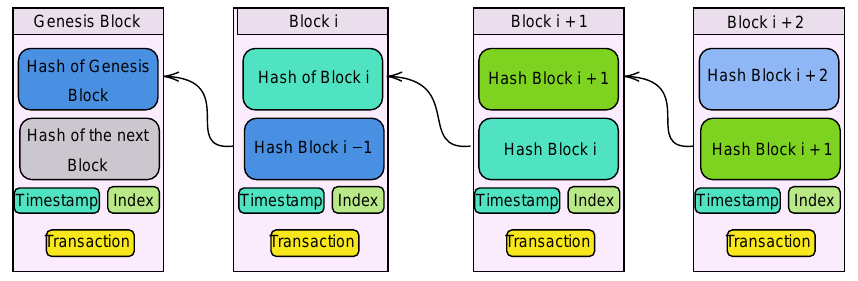
Figure 6. A representation of blocks in a typical blockchain